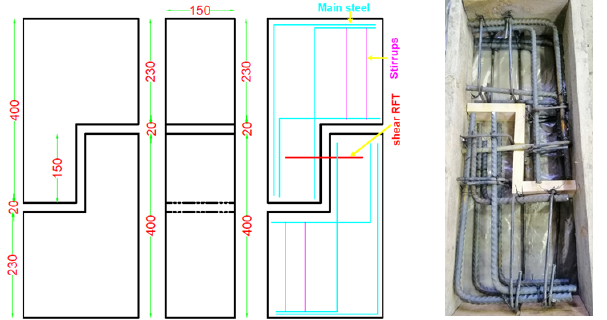
Figure 8: Dowel action test, sample details (dimensions and rein- forcement). All dimensions are in mm